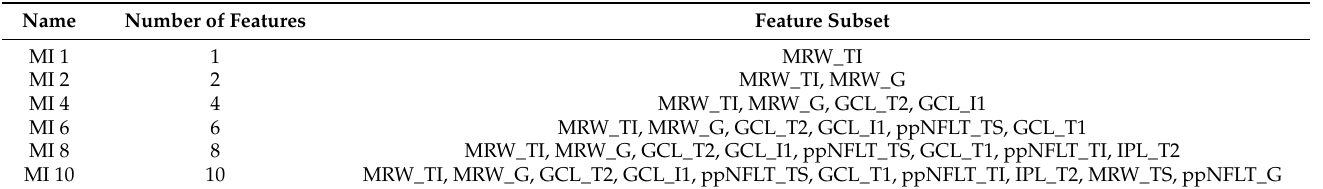
Table 7. Selected feature subsets with mutual information method.